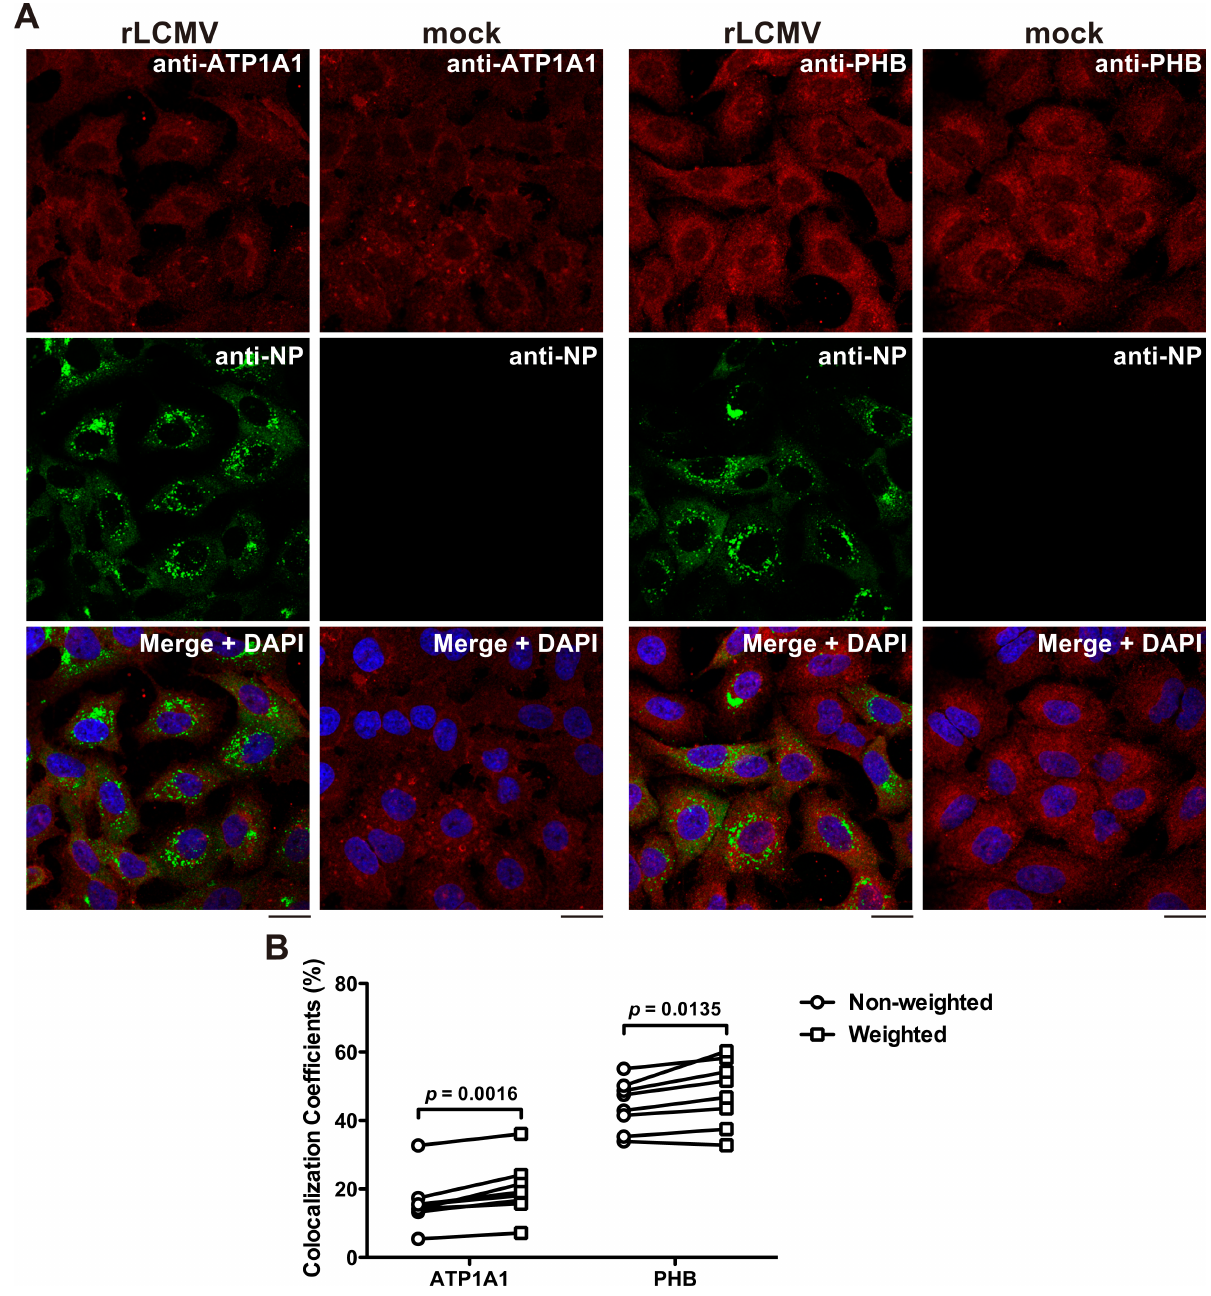
Fig 4. Co-localization of NP with ATP1A1 and PHB. (A) Intracellular distributions of NP and ATP1A1 or PHB. A549 cells seeded (5 x 10 4 cells/ well) in a 24-well plate and cultured overnight were infected (MOI = 0.1) with rLCMV Cl-13 or remained uninfected (mock). At 48 h pi, cells were fixed, stained with primary mouse anti ATP1A1 or PHB antibody followed by secondary anti-mouse IgG antibody conjugated with Alexa Fluor 568 (anti-mouse IgG-AF568). Subsequently, cells were stained with VL-4-AF488 (anti-NP), and observed by a confocal microscope. Bars, 20 μm. (B) Comparison of non-weighted and weighted co-localization coefficients (CC). Non-weighted CC were determined by dividing the sum of both green and red positive pixels by the sum of green-positive pixels. Thresholds were determined based on the signal intensity of mock-infected sample stained with VL-4-AF488 and anti-mouse IgG-AF568. Weighted CC were determined by taking into consideration the brightness of each channel signal. p values were determined by a two-tailed paired t test using GraphPad Prism software.